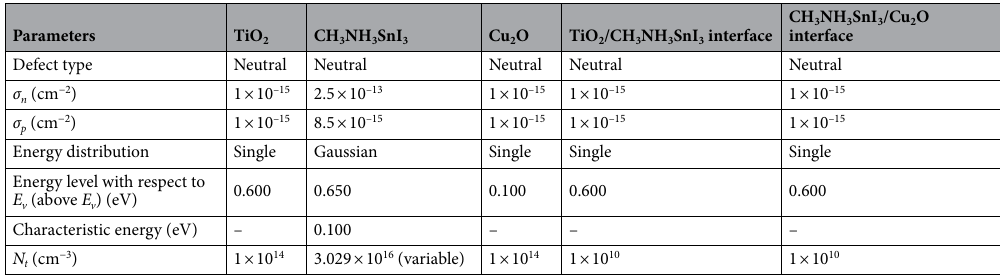
Table 2. Parameters for the defects in materials and at